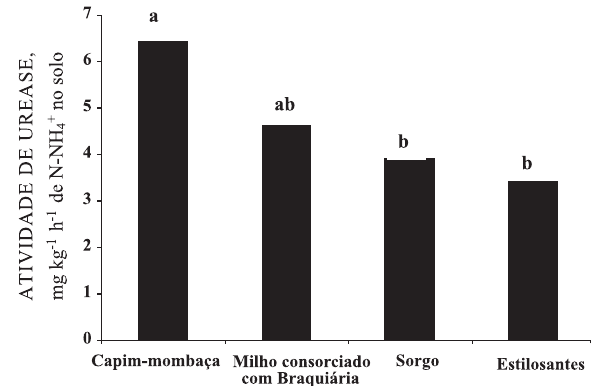
Figura 1. Atividade de urease na camada de 0–10 cm de solo no estádio de floração da cultivar de feijoeiro BRS Valente em função de plantas de cobertura. Médias seguidas pela mesma letra não diferem entre si pelo teste de Tukey (p < 0,05).